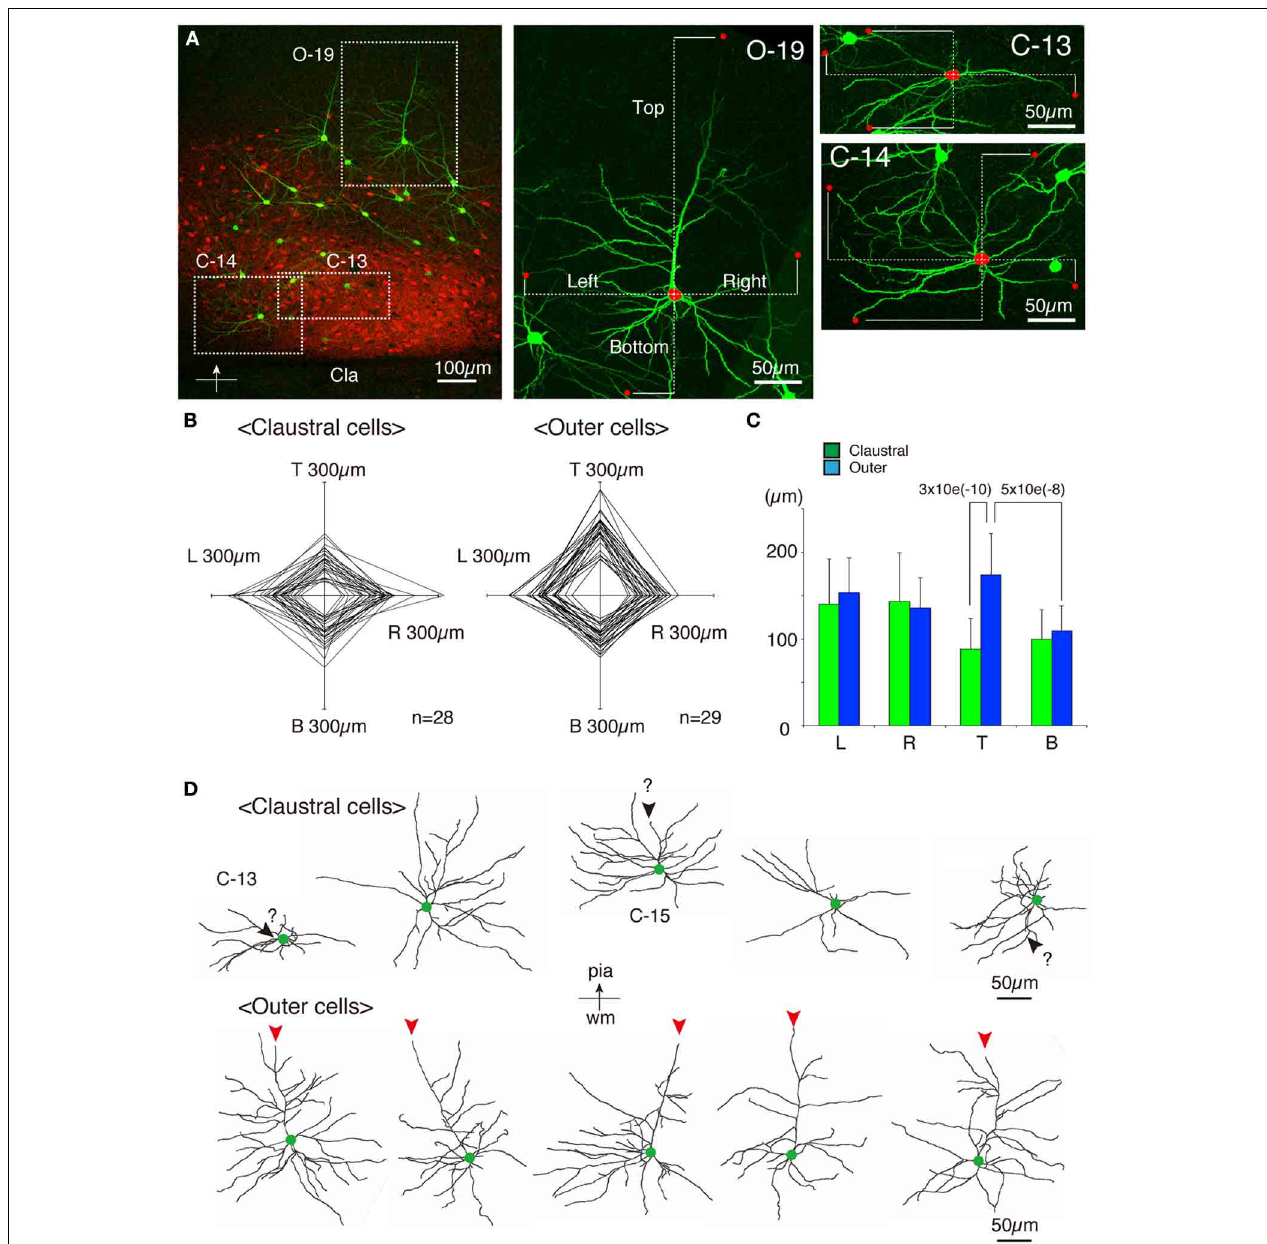
FIGURE 8 | Quantitative analysis of dendritic field extension for Lucifer-Yellow injected cells. (A) A typical example of the fluorescent image of the analyzed insular/claustral region. The axis of analysis (shown by the bar and the arrow at the bottom) was determined so that the pia is to the “Top.” This panel was taken from the same section shown in Figures 7E–G . Three analyzed cells, C-13, C-14, and O-19, were magnified on the right. The red dots on each cell indicate the tips of the dendrites that determined the “Top,” “Bottom,” “Right,” and “Left” borders of the dendritic field of the cell of interest. The distance from the center of the cell body to these borders were measured (dotted lines) to examine the polarity of dendritic extensions. Because we wanted to measure the overlaps between the insular and claustral territory, we measured the distance in these max projection images, and not the 3D distance from the tips to the cell body. (B) Rader plots for 28 claustral and 29 outer cells chosen from eight slices of two rats were superimposed. The ends of each axis correspond to 300 µ m from the center. The “claustral” cells were determined based on the counterstaining by